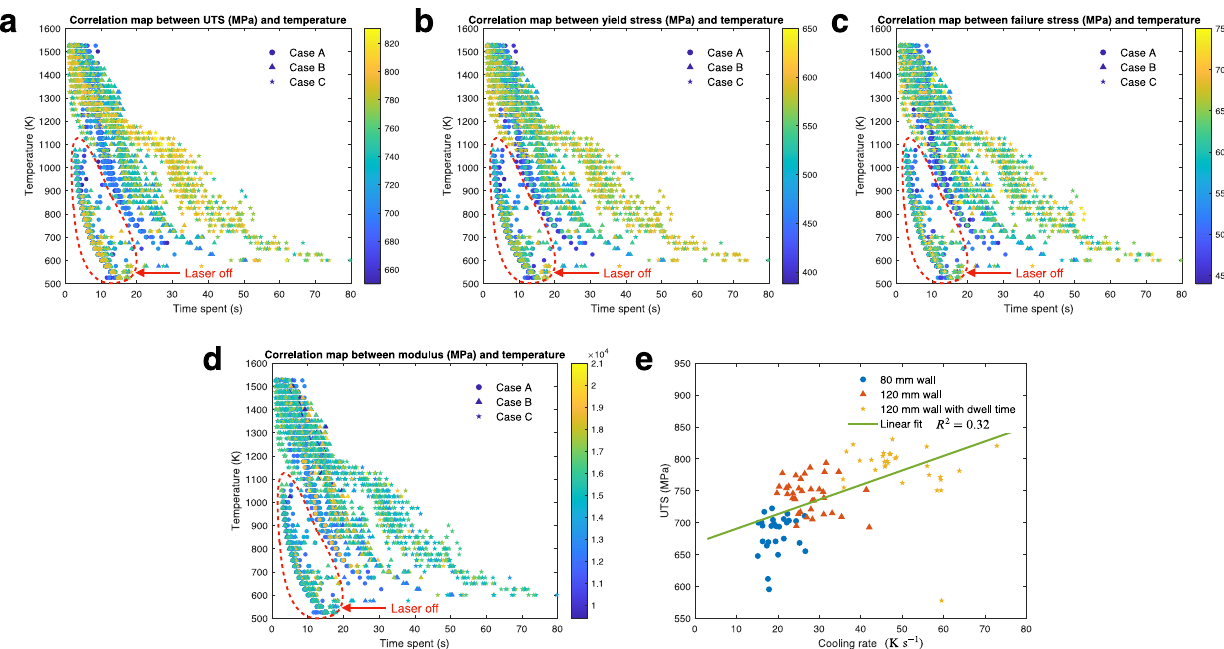
Fig. 6 Correlation between temperature and mechanical properties for three cases. a UTS b yield stress c failure stress d modulus. The location of each marker shows how much time was spent within each 25-degree temperature band. Details of temperature post processing is described in Methods and Supplementary Fig. 4. The color of each marker represents the value of the mechanical property for that sample. e Correlation between cooling rate and UTS for the three walls. The green line is the linear fi t to all data. The R 2 error for the fi t is